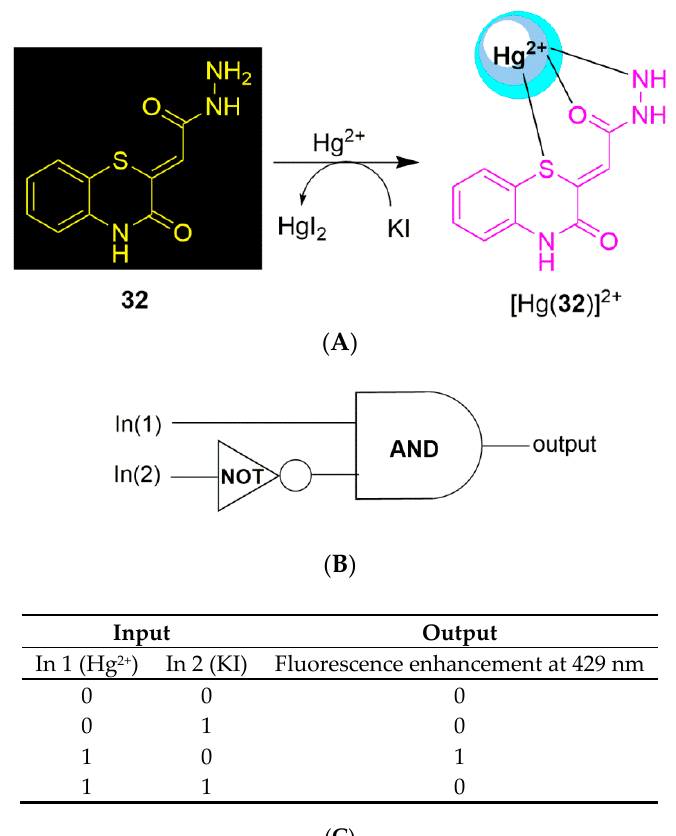
Figure 13. Molecular probe 32 , highlights the proposed binding environment and color and fluorescence changes ( A ) chemical scheme, ( B ) circuit diagram corresponding to the Hg 2 + and KI inputs and ( C ) truth tabled [194].